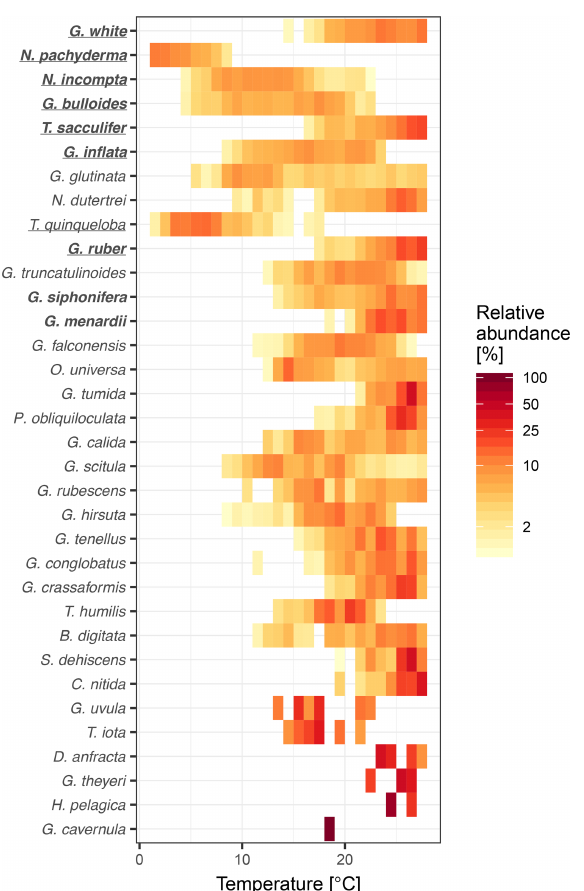
Figure 2. Species thermal niche ranked by average sedimentary abundance (top to bottom). Colours indicate average abundance (on a logarithmic scale) within 1 ◦ C bins. The essential species (see Fig. 1) for MAT are marked in bold and those for WA are un- derlined. Despite their apparently well-defined thermal niche, rare species are not essential for transfer functions and those that are important are all abundant.